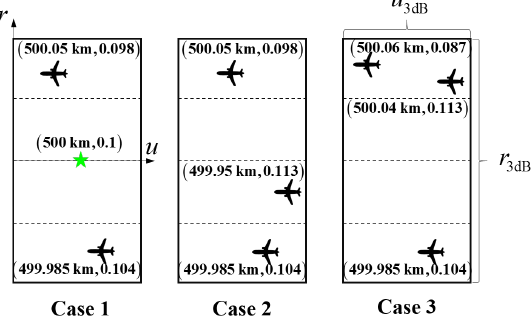
Figure 6. Three cases of multiple unresolved